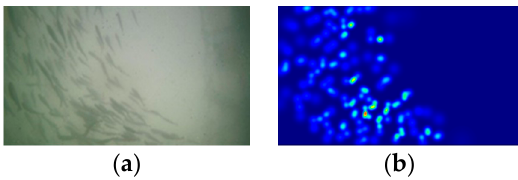
Figure 6. Diagram of density map: ( a ) original image and ( b ) corresponding density map.